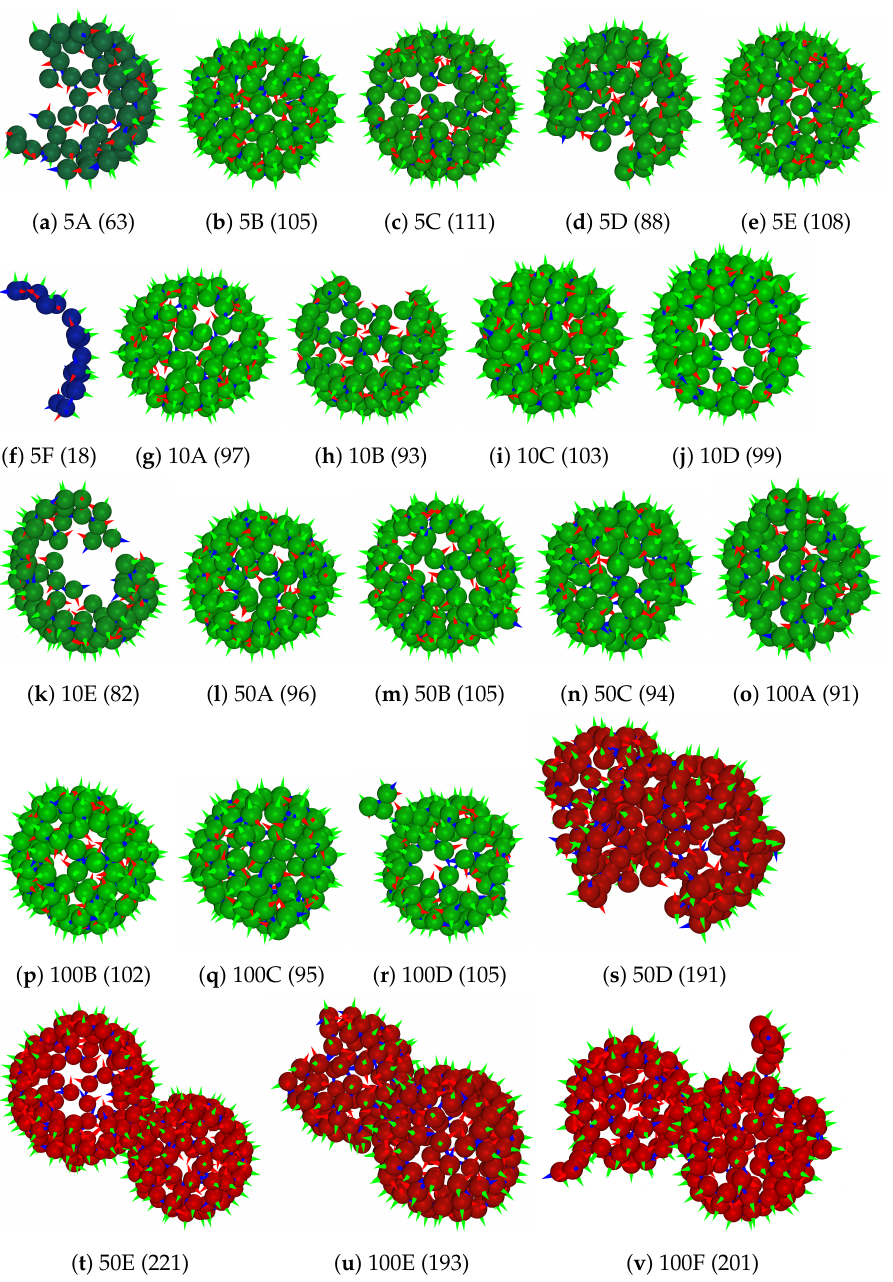
Figure 13. Magnified capsids marked in Figure 12 using visualization of dimers as spheres with orientation arrows ( x -axis red, y green, z blue). Numbers behind identifier indicate N SAS of structure. Colors match original coloring scheme according to N SAS in Figure